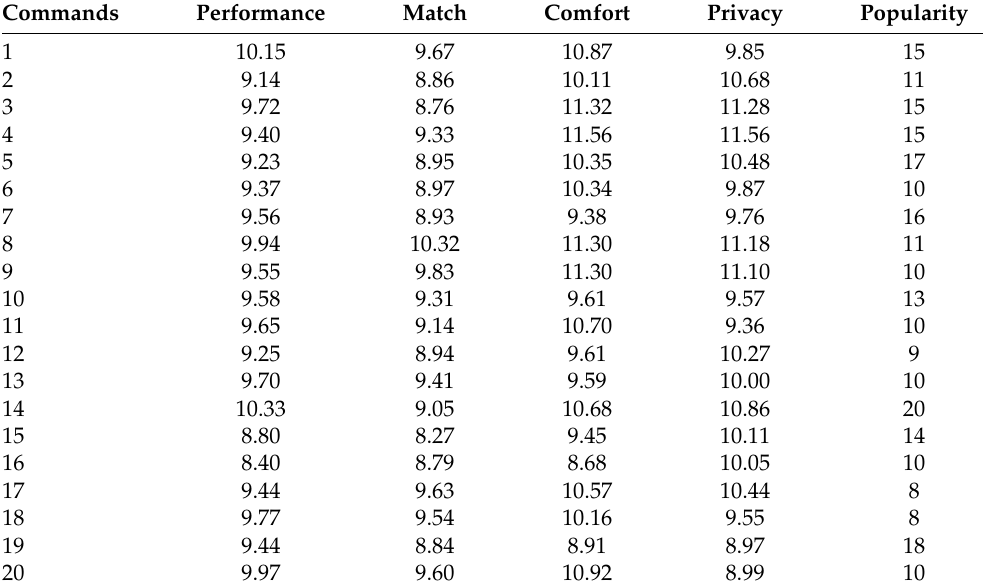
Table A2. The ratings and popularity of the proposed microgesture set among participants from China ( n = 22).